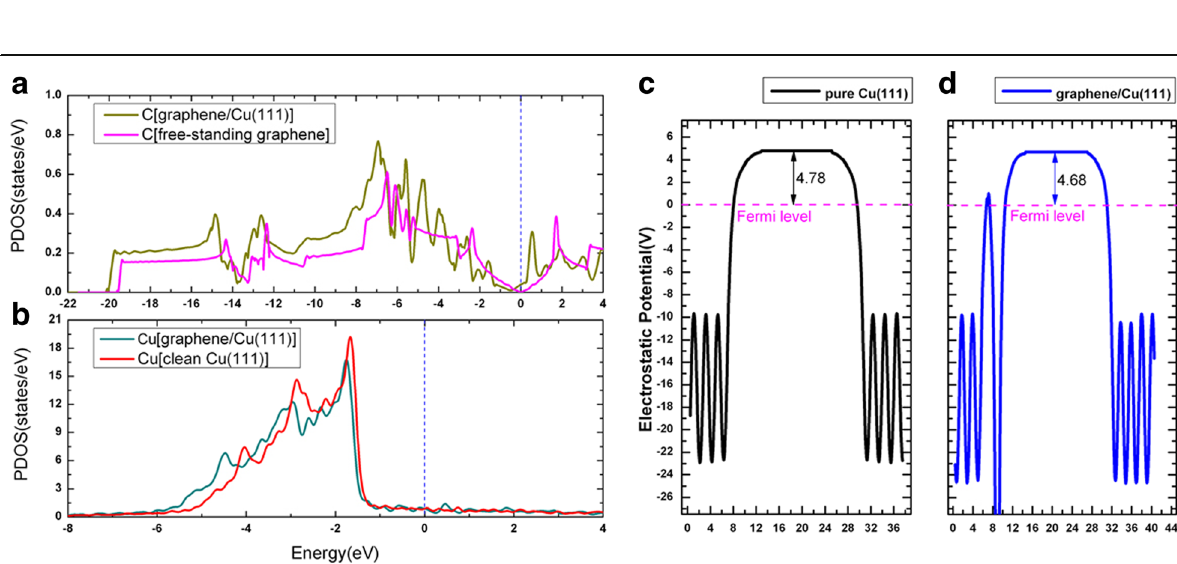
Fig. 7 Projected density of states of graphene/Cu(111) for a C atoms and b Cu atoms. c, d Work function of a clean Cu(111) surface and a graphene/Cu(111) interface, respectively